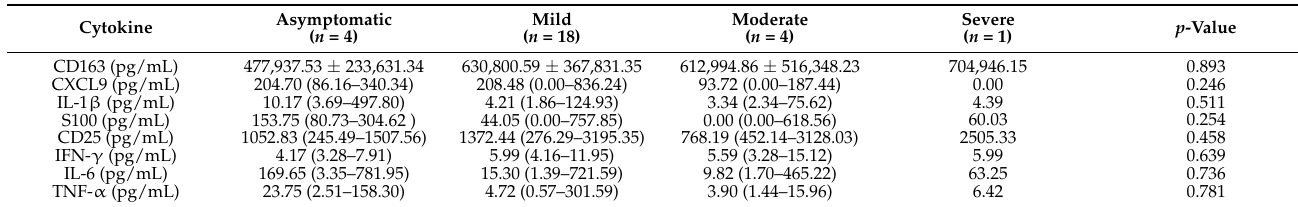
Table 2. Cytokine profiles in COVID-19 children with different severity disease.